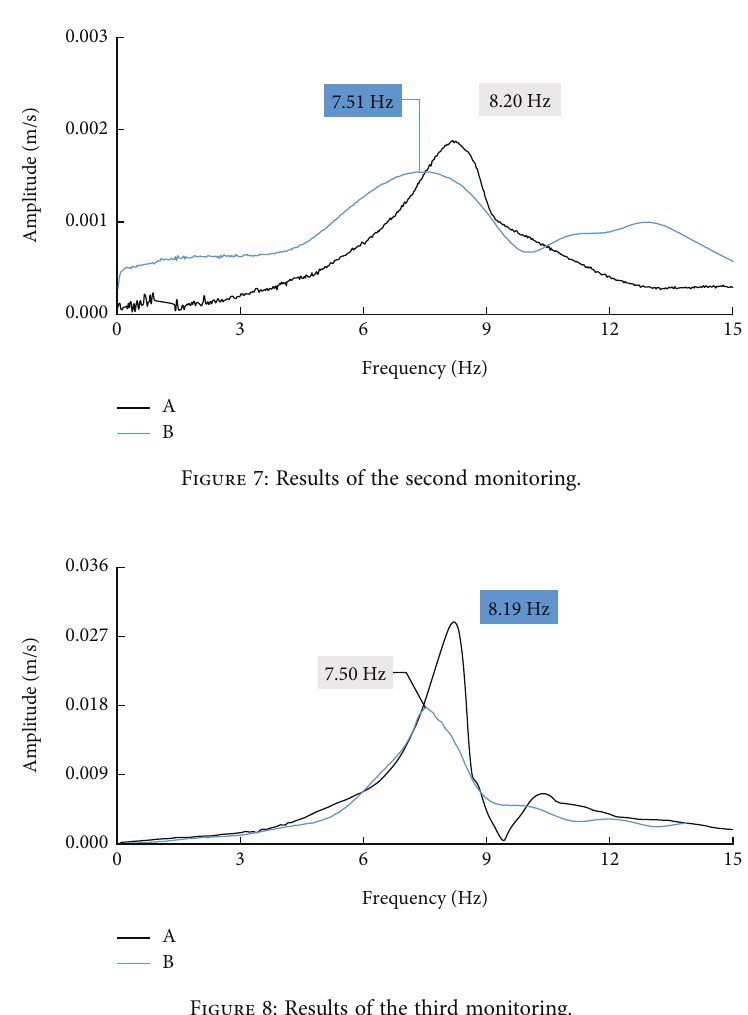
Figure 8: Results of the third